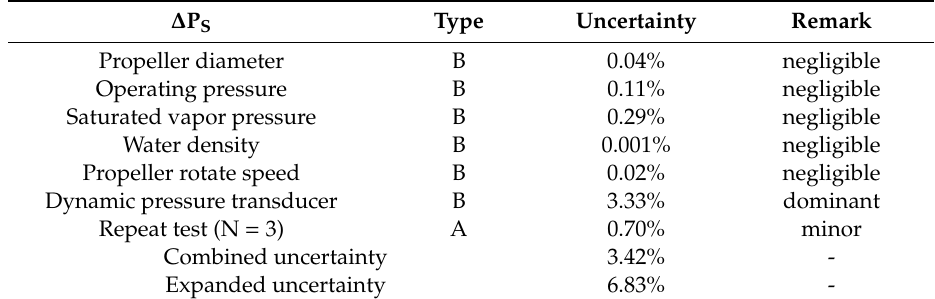
Table 7. The expanded uncertainty in measurement for the 1BF component of the hull pressure fluctuation in cavitating condition (at P10).